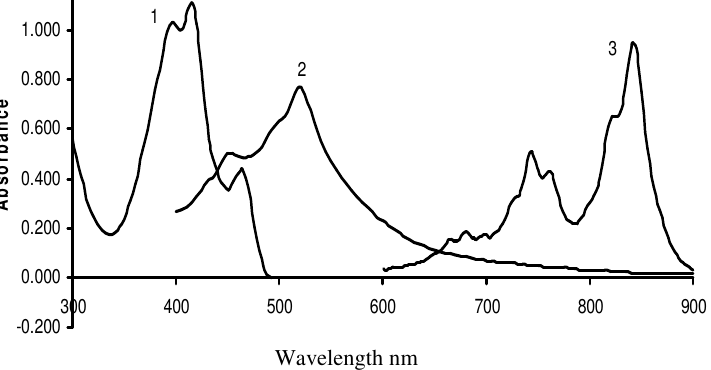
Figure 1 . Absorption spectra of the reaction products of PRE with each of TCNE (1), chloranil (2) and TCNQ (3). Concentrations of PRE were 250, 400 and 24 µg mL -1 in case of TCNE, chloranil and TCNQ, respectively. Solutions were in acetonitrile.